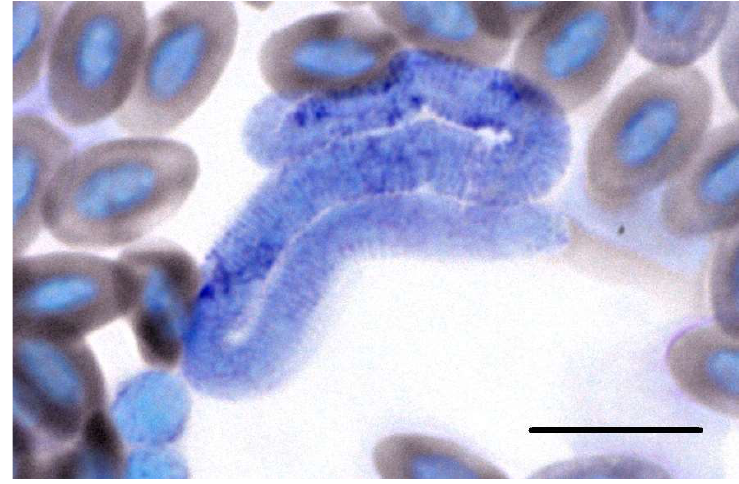
Figure 6. Larval stage (microfilaria) of Onchocercidae sp. isolate DANEW (OP006587 and OP006583) isolated from Newtonia amphicroa (Vangidae) in Madagascar. Scale bar = 10 µm . Four different 28S rRNA sequences were identified linked to five cox1 sequences. The 28S rRNA of Onchocercidae sp. isolate CROSSBAB was found in three M. crossleyi samples, but two different cox1 sequences were isolated from them (CROSSBAB and CROSSBAB2) with two basepair changes that distinguished these sequences. No sequence was shared between different bird species or families. No sequence was 100% homologous to previ- ously published sequences. Phylogenetic analysis (Figure 7) revealed close relatedness of the isolate from Tylas eduardi to Splendidofilaria bartletti , a nematode detected in a single Sylvia atricapilla from Lithuania [22]. The Onchocercidae sp. isolates CROSSBAB and CROSSBAB2 were quite ho- mologous, with just two basepair changes and formed an individual branch within the tree. All microfilariae isolated from Vangidae appeared in the same clade, whereas the isolate from Terpsiphone mutata (Monarchidae), Aproctella alesandroi isolate PARFLY was separated from them.